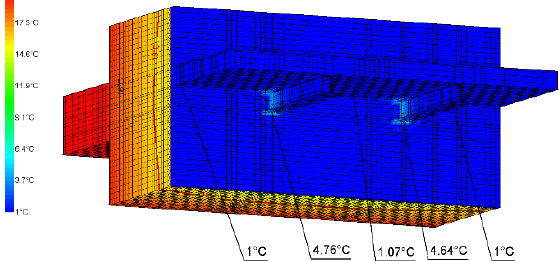
Figure 26. External surface temperature distribution field on the wall and bottom of the balcony.